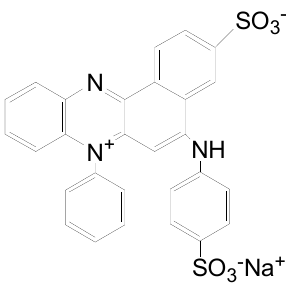
Figure 1. The molecular structure of Azocarmine G.